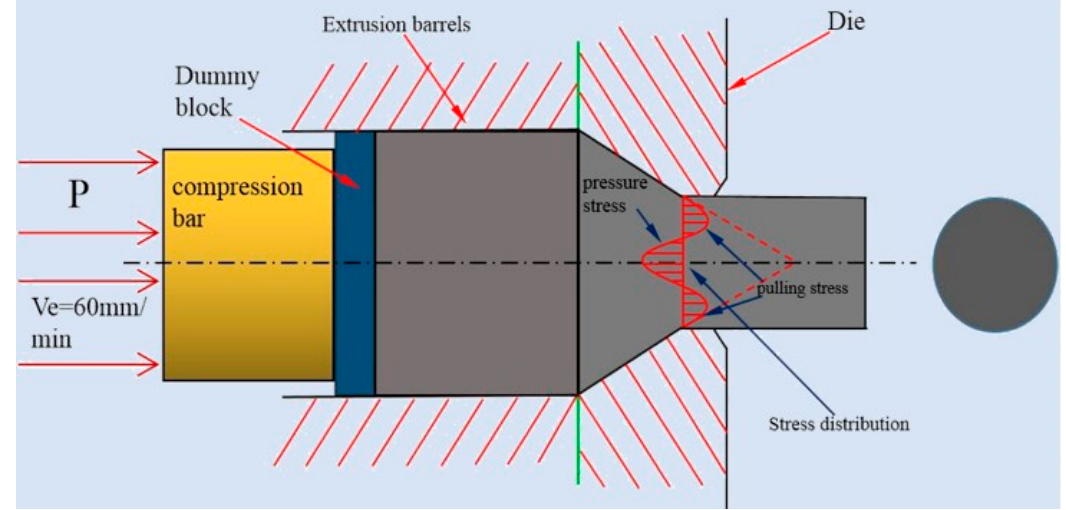
Figure 5. Schematic diagrams of extrusion.